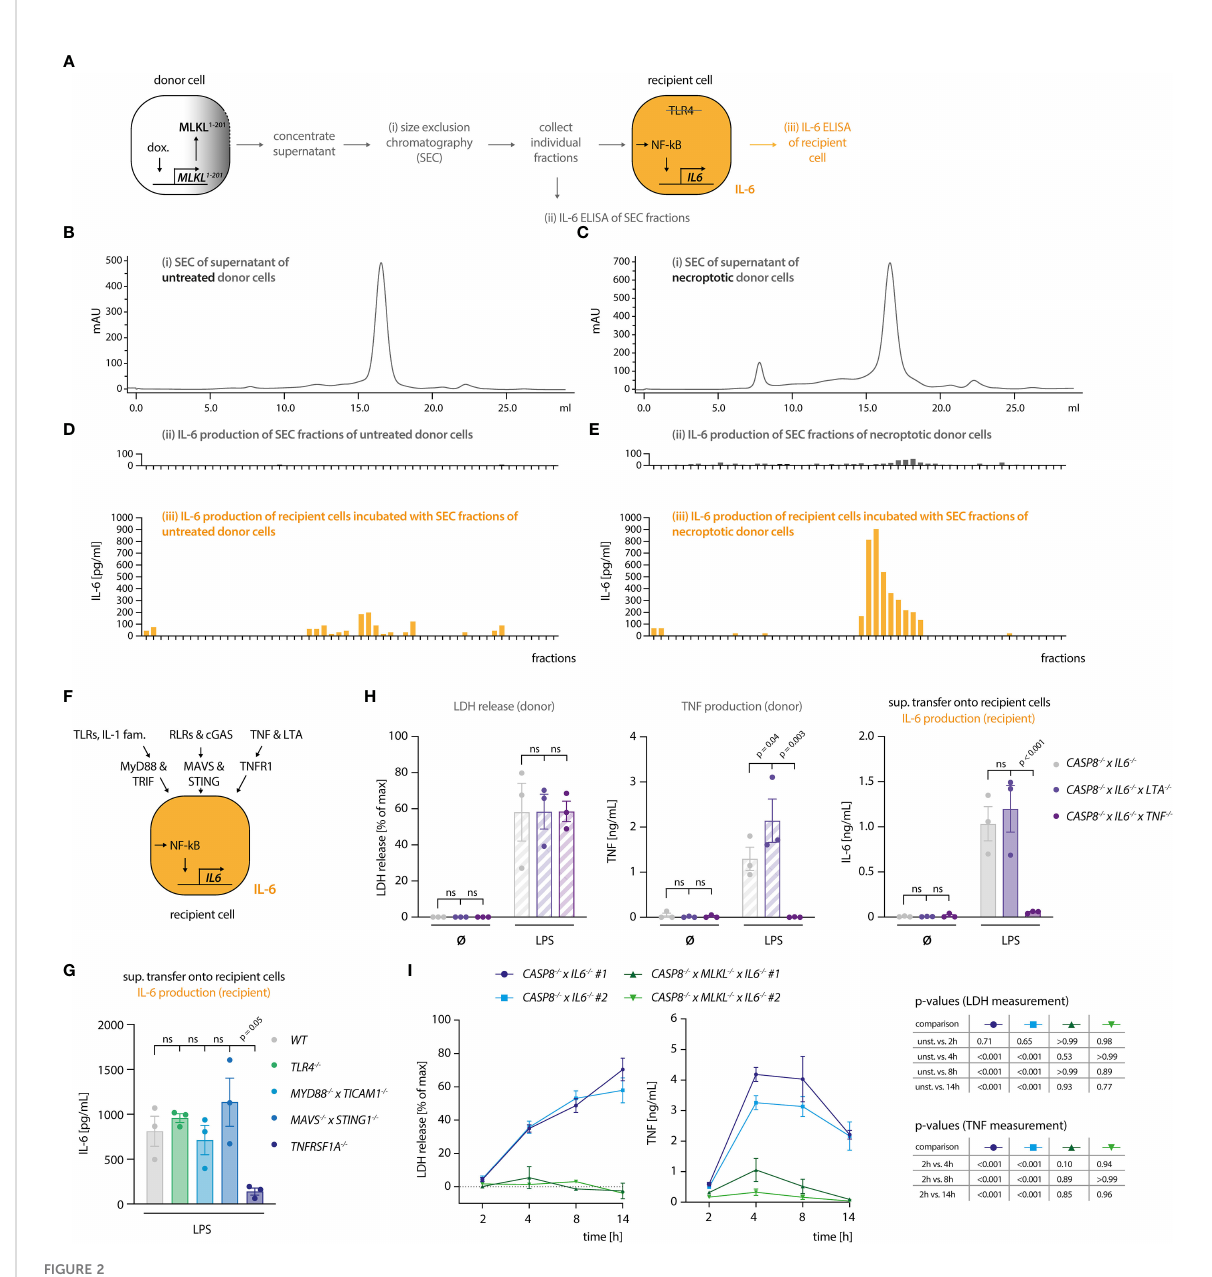
FIGURE 2 Necroptosis-driven in fl ammatory responses are mediated by TNF. (A) Schematic overview of the SEC experiment. (B, C) Chromatograms of the SEC of the supernatant of THP1 MLKL 1-201 cells left untreated (B) or stimulated with 1 µg/ml doxycycline for 16 h (C) . (D, E) IL-6 measurement in SEC fractions of untreated and treated THP1 MLKL 1-201 cells (in grey, upper graphs) and IL-6 production of TLR4 -/- BLaER1 recipient cells after incubation with SEC fractions for 14 h (in orange, lower graphs). (F) Scheme of knock-out generation in BLaER1 recipient cells to invalidate speci fi ed innate immune pathways. BLaER1 cells de fi cient for the indicated pathways were subsequently tested in the supernatant transfer assay. (G) Recipient cells of the indicated genotypes were incubated for 24 h with the supernatant of CASP8 -/- x IL6 -/- donor cells stimulated for 18 h with 2 ng/ml LPS. To block LPS-dependent effects, the TLR4 inhibitor CLI095 was added to recipient cells at the concentration of 1 µg/ml. IL-6 production of recipient cells was measured. (H) BLaER1 cells of the indicated genotypes were stimulated with 2 ng/ml LPS or left untreated for 18 h, after which LDH and TNF release were measured. The supernatant of these cells was utilized to stimulate TLR4 -/- BLaER1 cells. IL-6 release by TLR4 -/- cells was measured 24 h thereafter. (I) BLaER1 cells of the indicated genotypes were stimulated with 2 ng/ml LPS for the indicated time points. LDH release and TNF secretion from donor cells of the speci fi ed genotypes were measured at the indicated time points. Data are depicted as mean ± SEM of 3 independent experiments (G – I) or as one representative experiment of two independent experiments (B-E) . Statistics indicate signi fi cance by one-way (G) or two-way ANOVA (H) or a repeated measures two-way ANOVA (I) with a Dunnett (G – I) correction for multiple testing. P values as indicated or ns, not signi fi